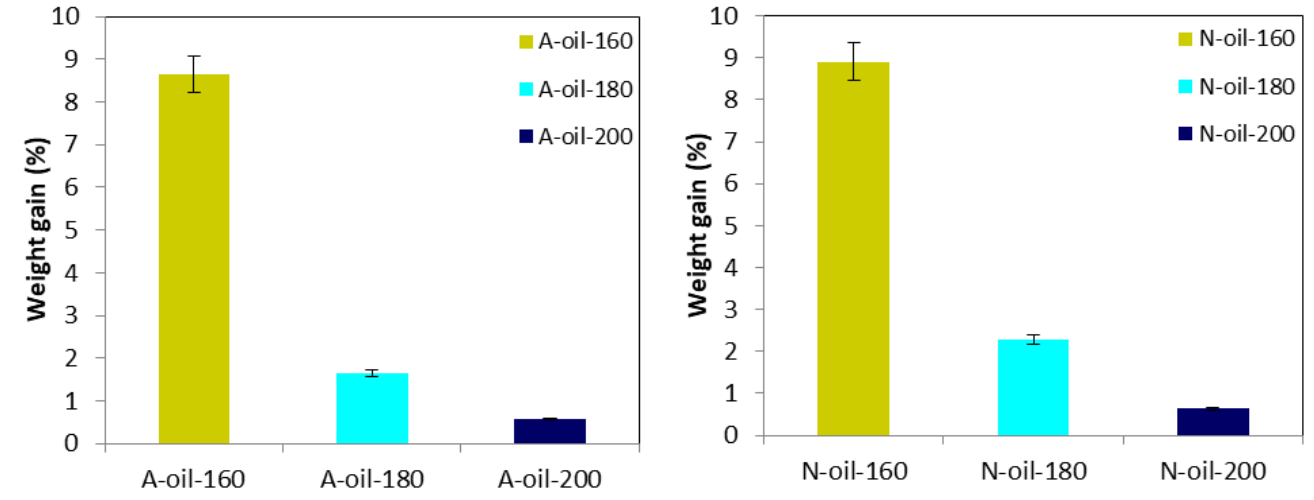
Figure 4. Weight percentage gain of Afrormosia and Newtonia heat-treated under palm oil.